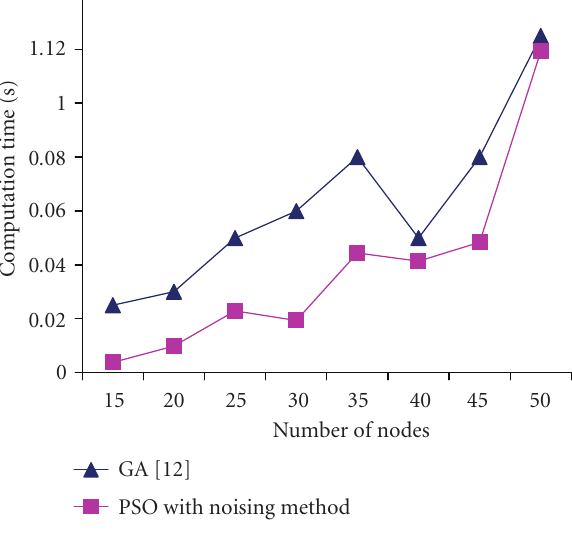
Figure 4.8 . Comparison of convergence time between proposed hybrid PSO and GA